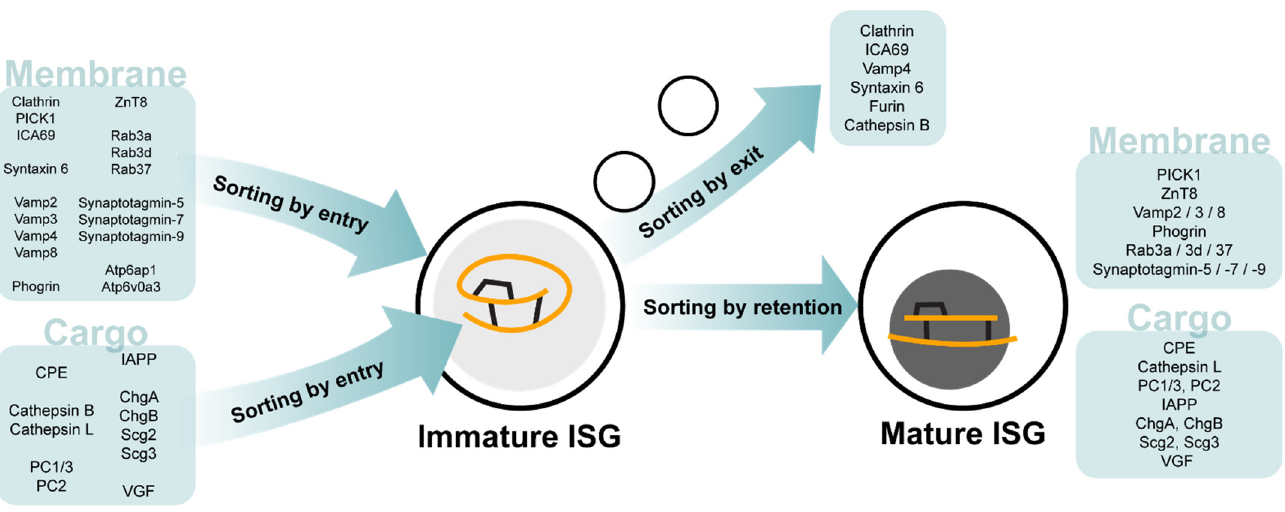
Figure 2. ISG membrane and cargo proteins of the immature and mature ISG. ISG proteins associated with the ‘sorting by entry ’, ‘ sorting by exit ’ and ‘ sorting by retention ’ steps of ISG biogenesis and maturation